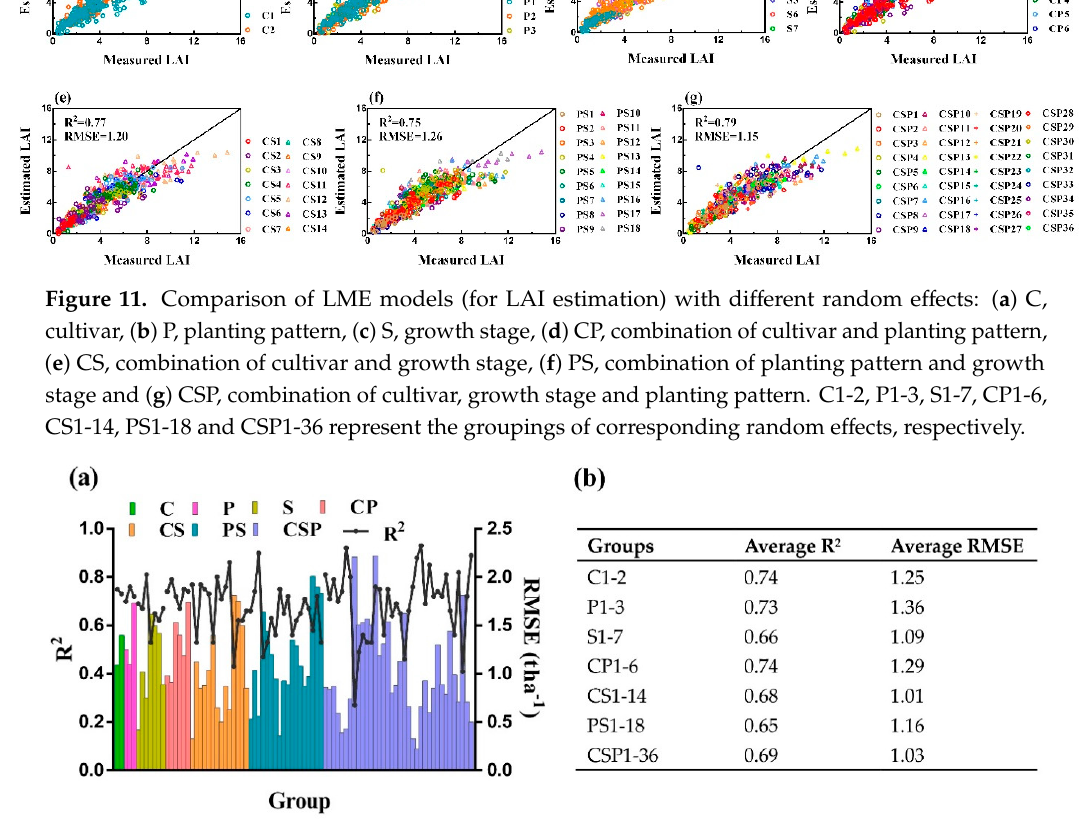
Figure 12. Comparison of predictive capability within the groups of LME models (for LAI estimation)